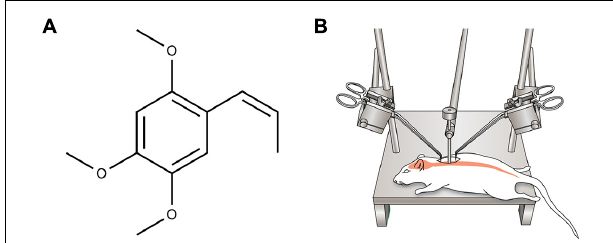
FIGURE 1 | (A) Chemical structure of α -asarone. (B) A schematic diagram showing moderate static compression spinal cord injury (SCI) rat model induced by imposing 35 g of static weight on the dorsal surface of the T10 spinal cord for 5 min.